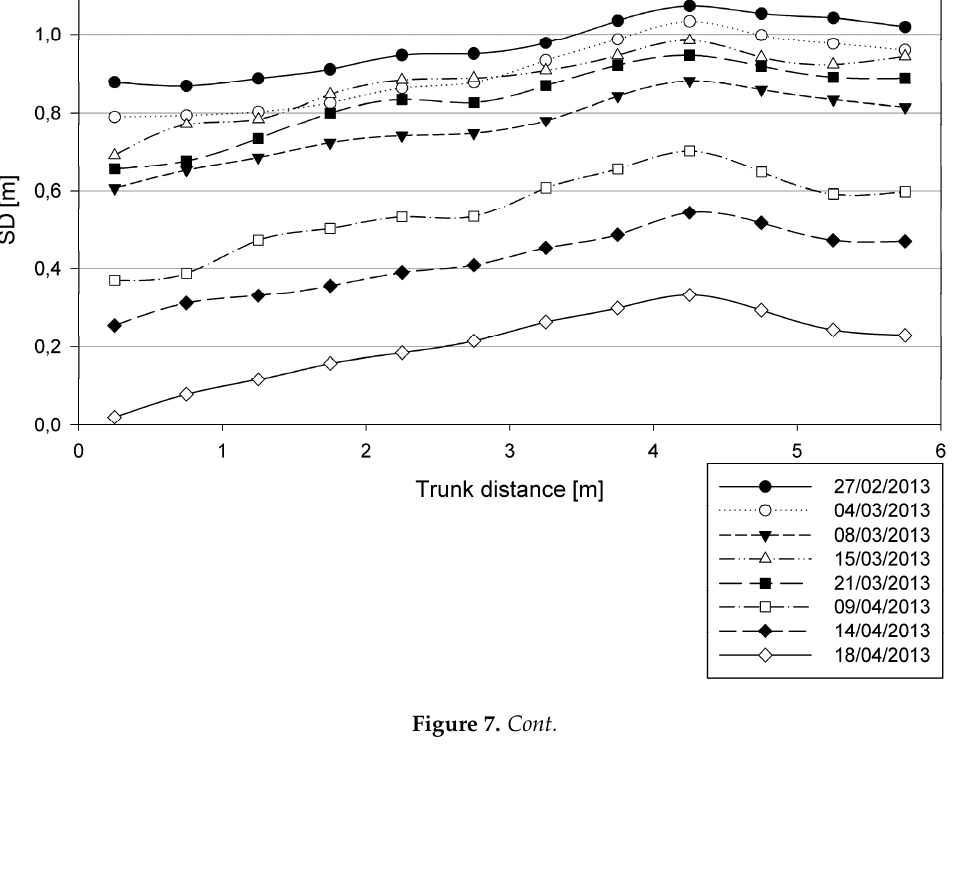
Figure 7. Average snow depths as a function of distance from the tree trunk, for PCA component C1 prior to ( a ) and following canopy pruning ( b ). 4. Discussion In this study we made the first evaluation of the impact of pruning of the lower crown branches of trees in a small Pinus sylvestris stand in the central Spanish Pyrenees on the accumulation and melting dynamics of the snowpack. The snow depth was measured at a very high spatial resolution (0.25 m) using a TLS. The study period comprised three snow seasons. The type of canopy pruning performed at the Balneario de Panticosa study site is a widespread procedure used at forested sites to prevent the spread of fire; its purpose is to increase the distance between the ground and the base of the canopy to 3–3.5 m [25]. The pruning in this study was undertaken prior to the third year in which snowpack depth measurements were made. The acquisition of high spatial resolution data on